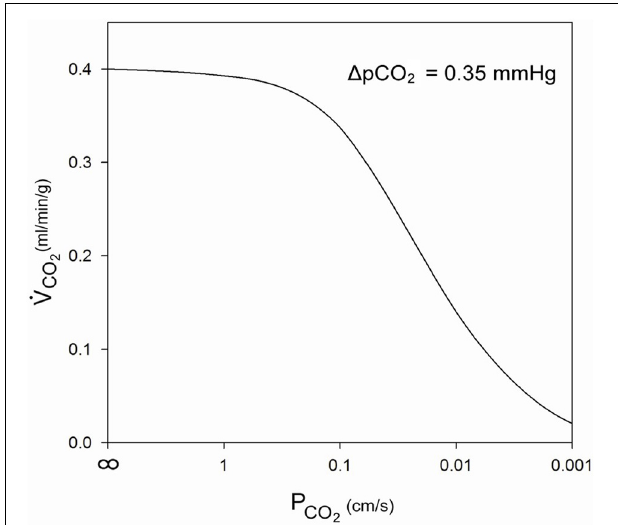
FIGURE 4 | Influence of membrane CO 2 permeability on CO 2 release from a maximally metabolizing cardiomyocyte at a given partial pressure gradient of 0.35mmHg over the half-thickness of the